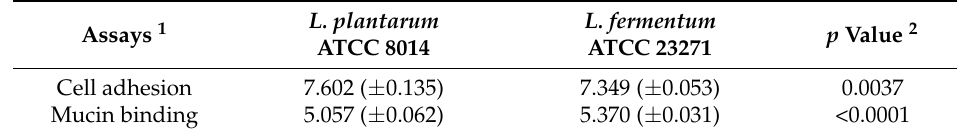
Figure 3. Microscopic visualization of adhesion assays of ( a ) L. plantarum ATCC 8014 and ( b ) L. fermentum ATCC 23271 to HeLa cells after inoculation of approximately 10 7 CFU of bacterial suspensions. Cell monolayers grown on coverslips were stained by the Gram’s method and examined by light microscopy under a 100× oil immersion objective. Note the presence of numerous gram-positive bacilli adhered to HeLa cells. Table 4. Adherence quantification of L. plantarum ATCC 8014 to HeLa cells and to mucin in comparison with the control.